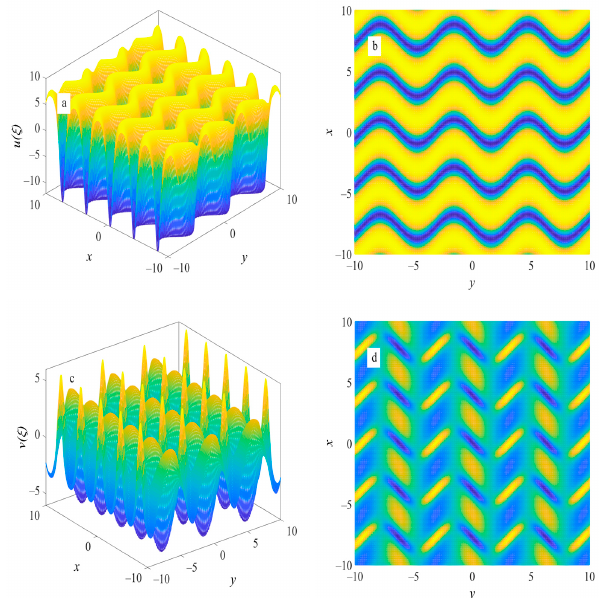
Figure 4. ( a ) Three-dimensional and ( b ) two-dimensional contour plots represent the s-type wave structure of Equation (35) and ( c ) three-dimensional and ( d ) two-dimensional contour plots represent the breather wave structure of Equation (36) when 𝑘 = 2, 𝑚 = 0.6, 𝜆 = 1,𝑡 = 1 and 𝜔 = 16 .